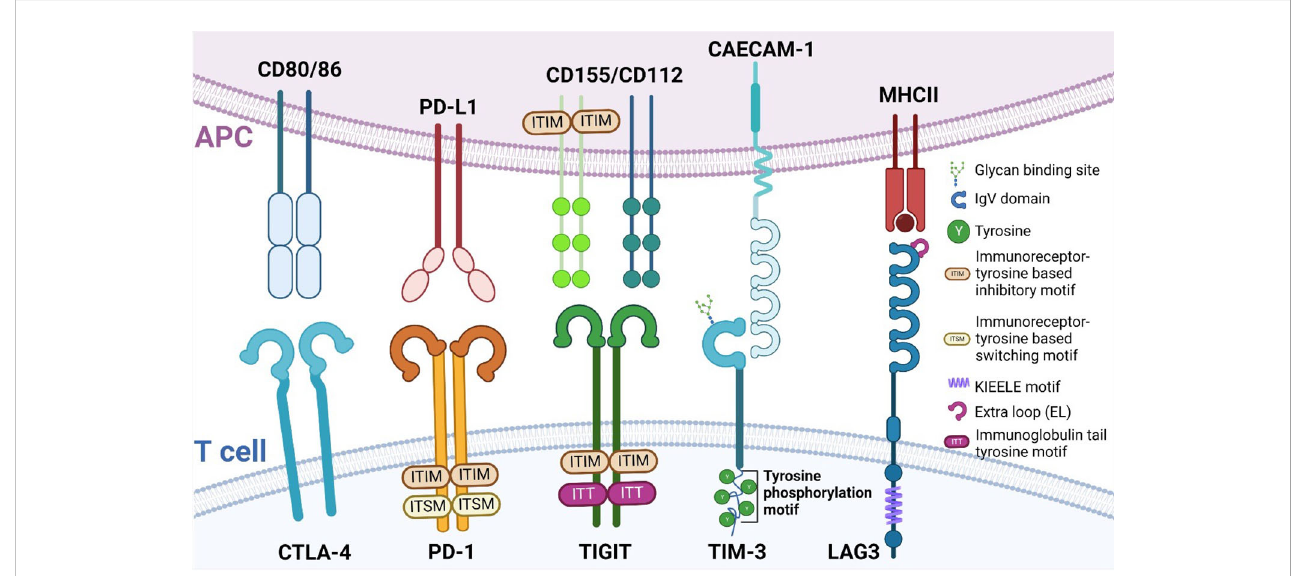
FIGURE 1 Structure of different immune checkpoints. Immune checkpoints and their structure expressed on T cells (bottom) and their respective ligands expressed on APCs (top). Depicted here are CTLA-4, PD-1, TIGIT, TIM-3 and LAG3. APC, antigen presenting cell; CTLA-4, Cytotoxic T lymphocyte antigen 4; PD-1, Programmed Death-1; TIGIT, T cell immunoglobulin and ITIM domain; TIM-3, T cell immunoglobulin domain and mucin domain 3; LAG3, lymphocyte activation